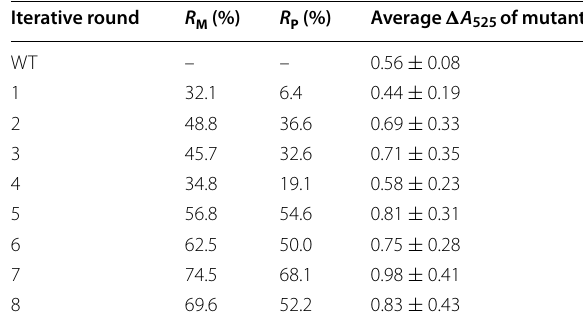
Table 2 Mutation and screening results for each round of ARTP mutagenesis